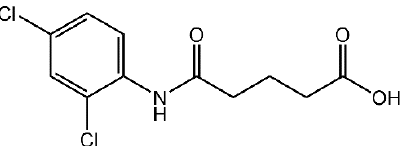
Figure 1. Chemical diagram for 4-[(2,4-dichlorophenyl)carbamoyl]butanoic acid ( 1 ).